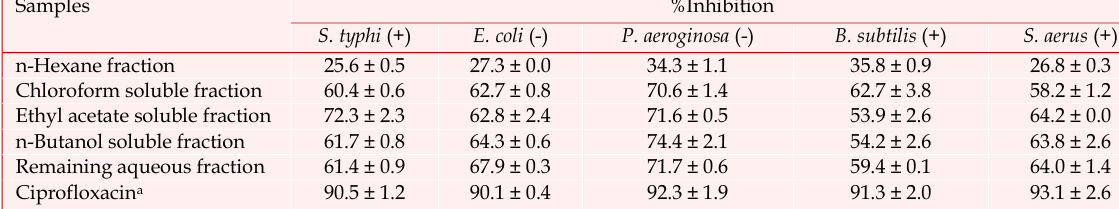
Percentage inhibition of various fractions of R. sceleratus against Gram-positive and Gram-negative